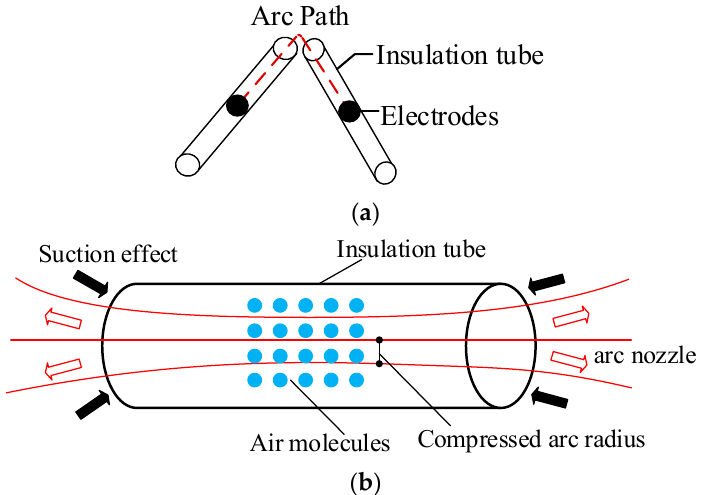
Figure 2. Schematic diagram of the internal space structure. ( a ) Insulation tube space structure; ( b ) effect on the arc.